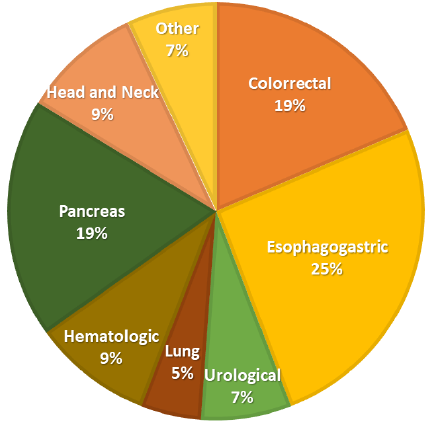
Figure 1. Distribution of oncological disease. The values of the morphofunctional study showed differences according to the sex in most of the variables except in ultrasonography measures adjusted for height, in the muscle mass/adipose tissue index (MAI) and in the phase angle (Table 1) Table 1. Differences in morphofunctional assessment between sex.